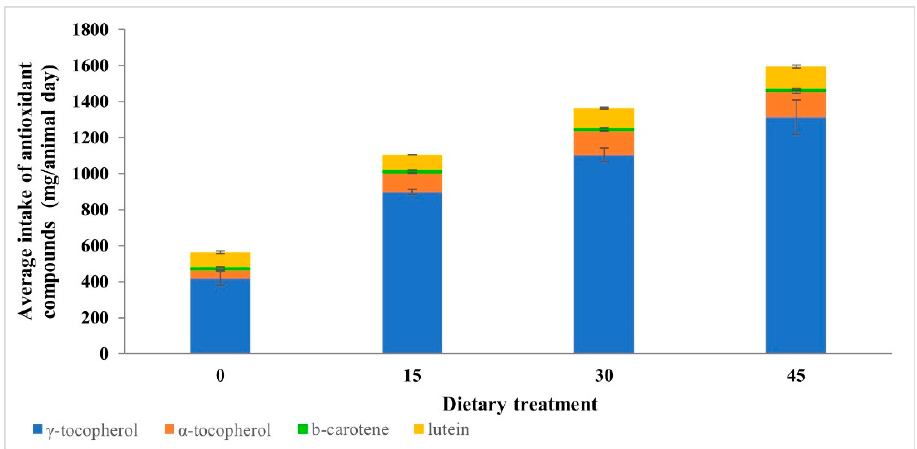
Figure 1. Average intake (mean ± SD) of antioxidant compounds weighted with the consumption of the animals, for each dietary treatment (0, 0% DG control; 15, 15% DG; 30, 30%DG; 45, 45% DG, DM basis).